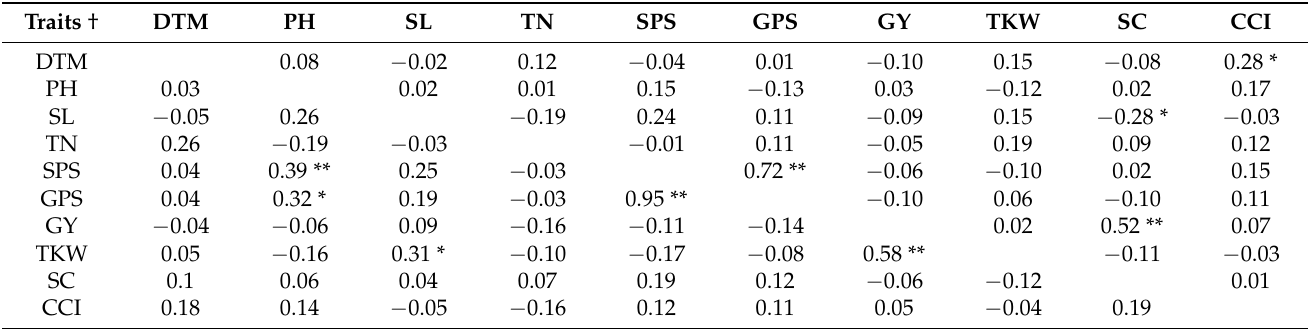
Table 5. Pearson correlation coefficients showing association between studied agronomic and physio- logical traits among wheat genotypes under irrigated (lower diagonal) and terminal drought (upper diagonal) in the GH